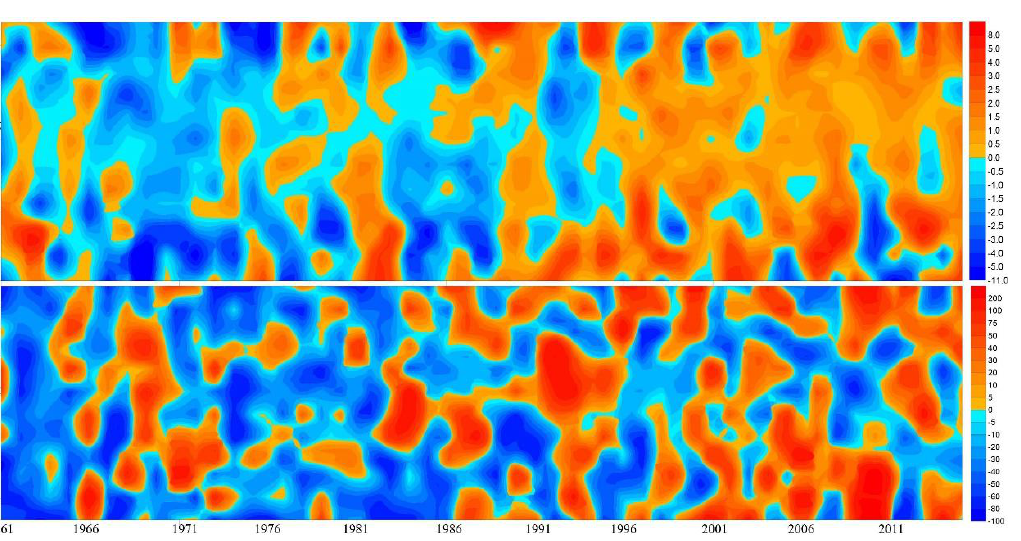
Figure 2. Variations in anomalies of ( a ) monthly air temperature (°C) and ( b ) precipitation (%) between 1961 and 2015 observed by CMA in the SAM.